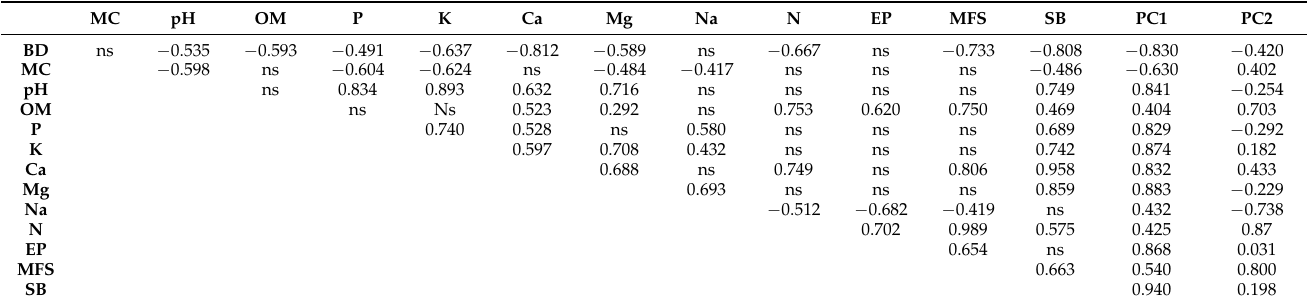
Table 2. Pearson correlation matrix between soil variables and the first two factors of the PCA (PC1, PC2).